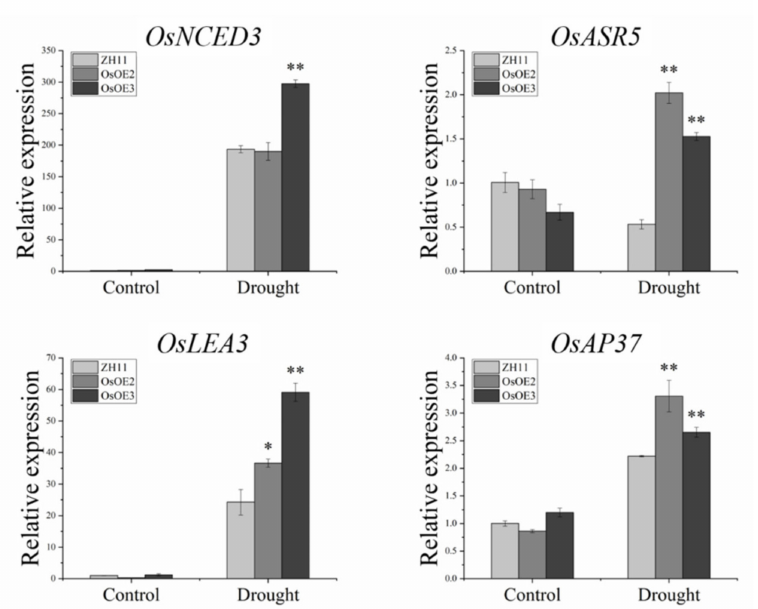
Figure 9. Expression analysis of ABA-related and drought-related genes in transgenic rice after drought treatment. Three biological replicates were used for each experiment. The OsActin-1 gene was used as the internal control for normalization. Vertical bars indicate means ± SEs ( n = 3). *, p < 0.05; **, p < 0.01 (Student’s t